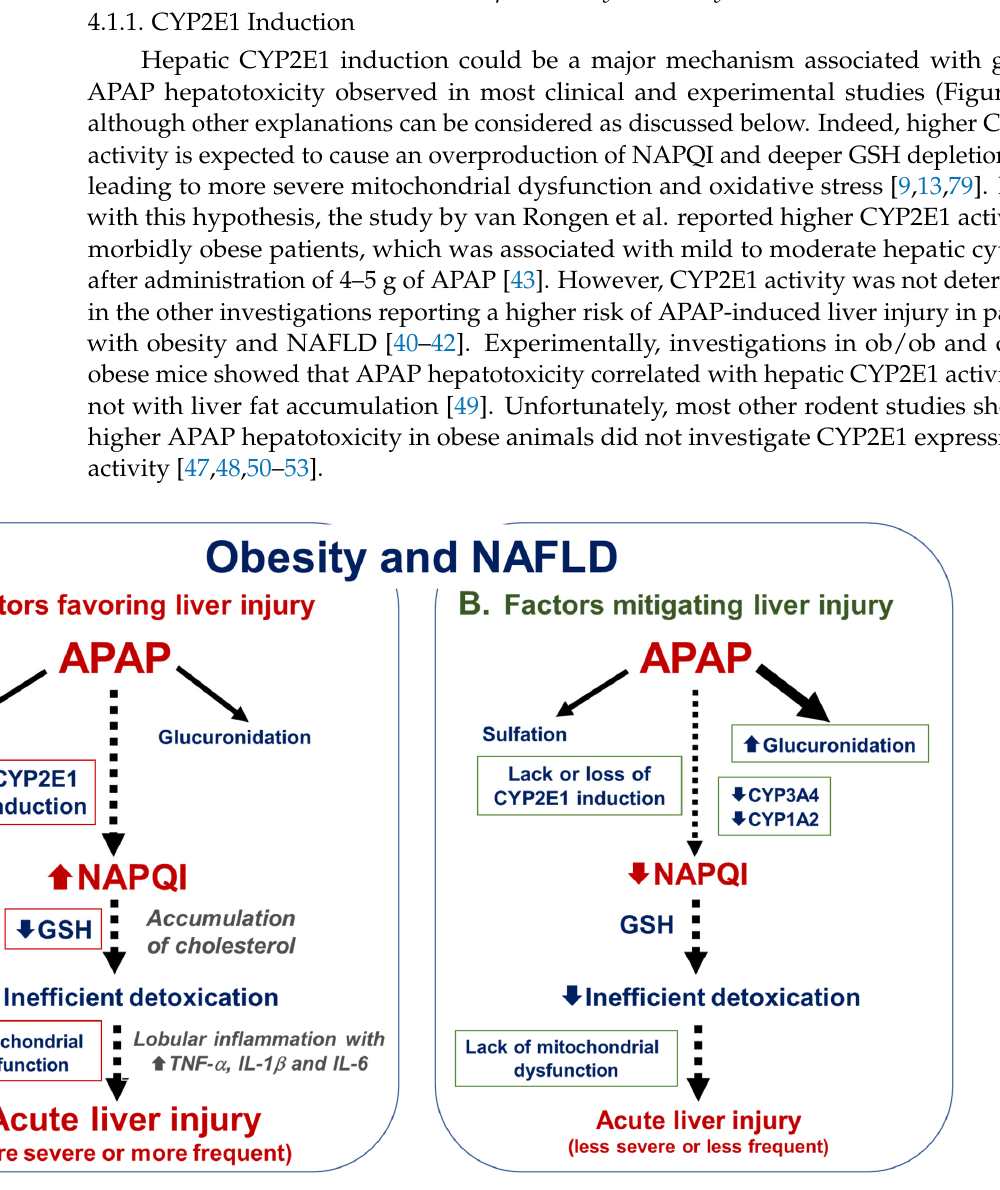
Figure 2. Hepatotoxicity of APAP in obesity and NAFLD. ( A ). Different factors in obesity